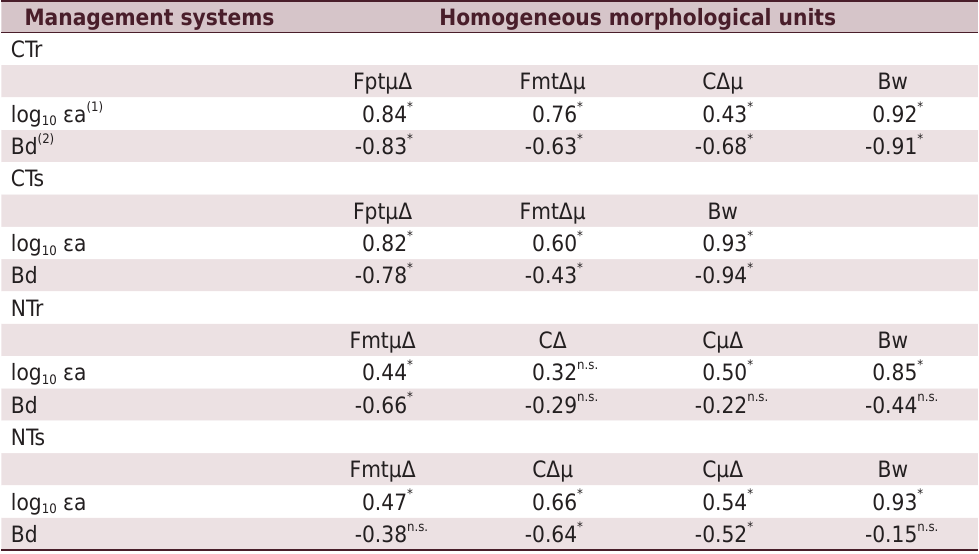
Table 3. Pearson correlation between air permeability (log 10 K a +1) and bulk density and aeration porosity in the homogeneous morphological units (HMU) identified under